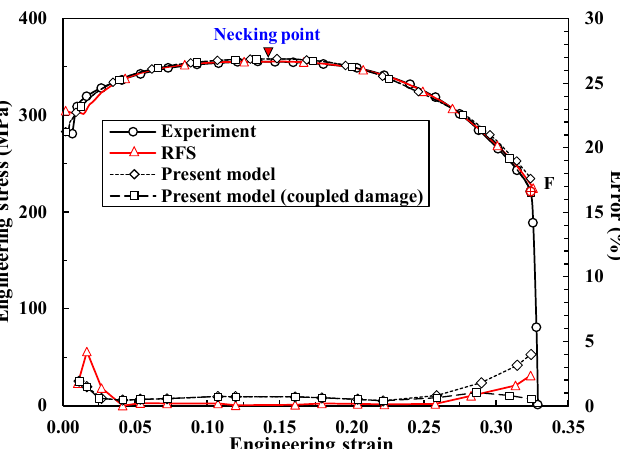
Figure 8. Comparison of the predictions of our damage-coupled model, the RFS, and the coupling- free model with the experimental tensile test.